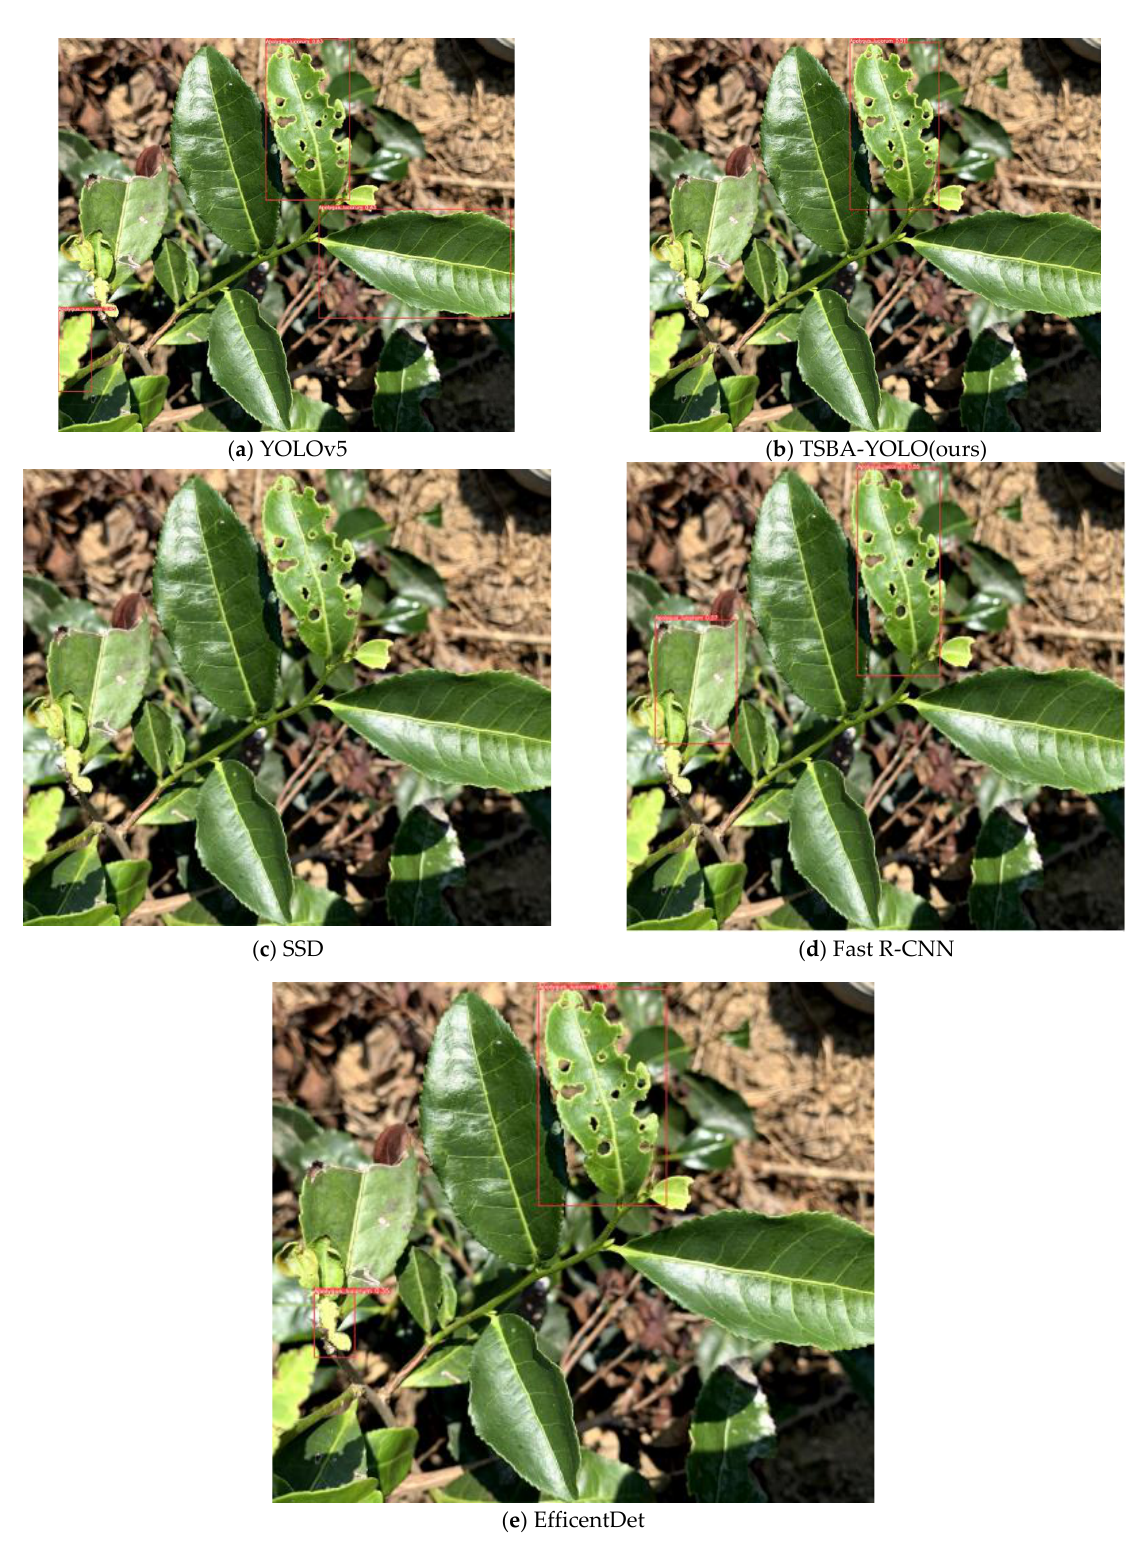
Figure 19. Comparison of global information extraction capabilities of different models. ( a – e ) are the detection results of the different models.